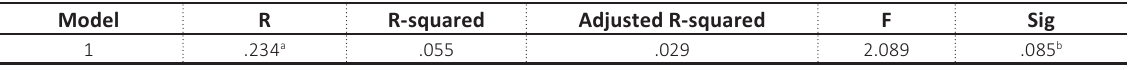
Table 4a. Multiple regression showing the composite influence of demographic factors on teacher